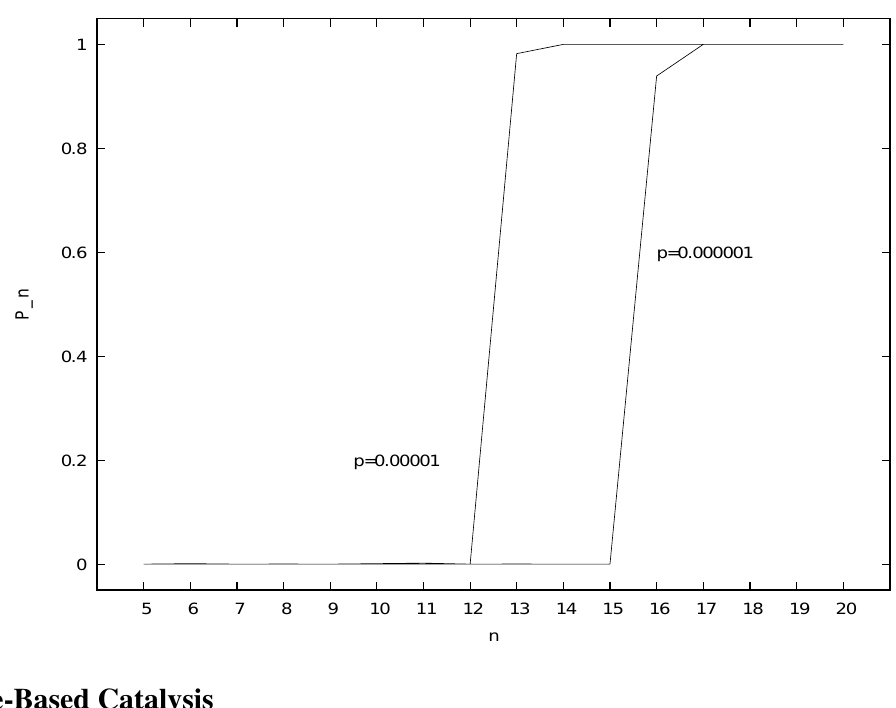
Figure 3. The probability P p and values of n